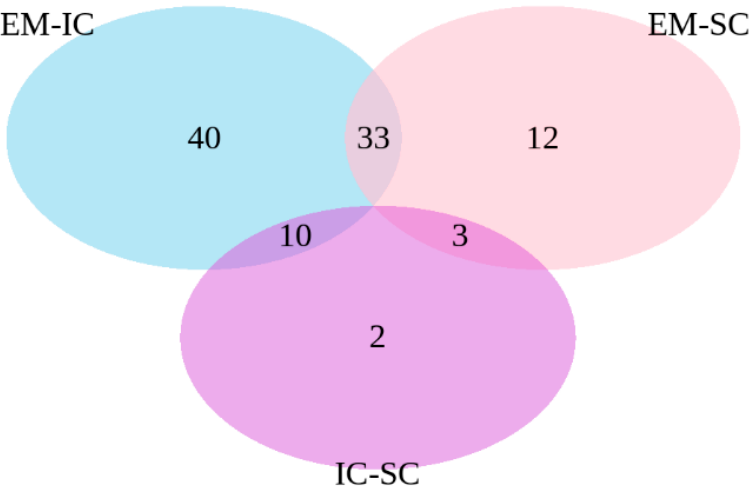
Figure 2. Venn diagram of differentially expressed genes between EM vs. IC, IC vs. SC and EM vs. SC. EM = entire males; IC = immunocastrated pigs; SC = surgically castrated pigs. Among the genes that were chosen based on the RNA-seq results (i.e., COL1A2— collagen type I alpha 2 chain, G6PD—glucose-6-phosphate dehydrogenase, GADD45G— growth arrest and DNA damage inducible gamma, PAPPA-2—pappalysin 2, PCK1— phosphoenolpyruvate carboxykinase 1, SCD—stearoyl-CoA desaturase and HSP70.2—heat shock protein family A member 1B), several differed significantly also using the qPCR approach (Figure 5b). The genes COL1A2 and PAPPA-2 were upregulated in EM compared with IC and SC ( p < 0.001), the gene HSP70.2 was upregulated in EM and IC compared with SC, while the genes G6PD and SCD were downregulated in EM compared with IC and SC ( p < 0.01). Most of the genes were regulated in the same direction in RNA-seq and qPCR approaches, except the GADD45G gene for which no significant differences were found between any of the pair-wise comparisons in the case of qPCR validation (Supplementary Figure